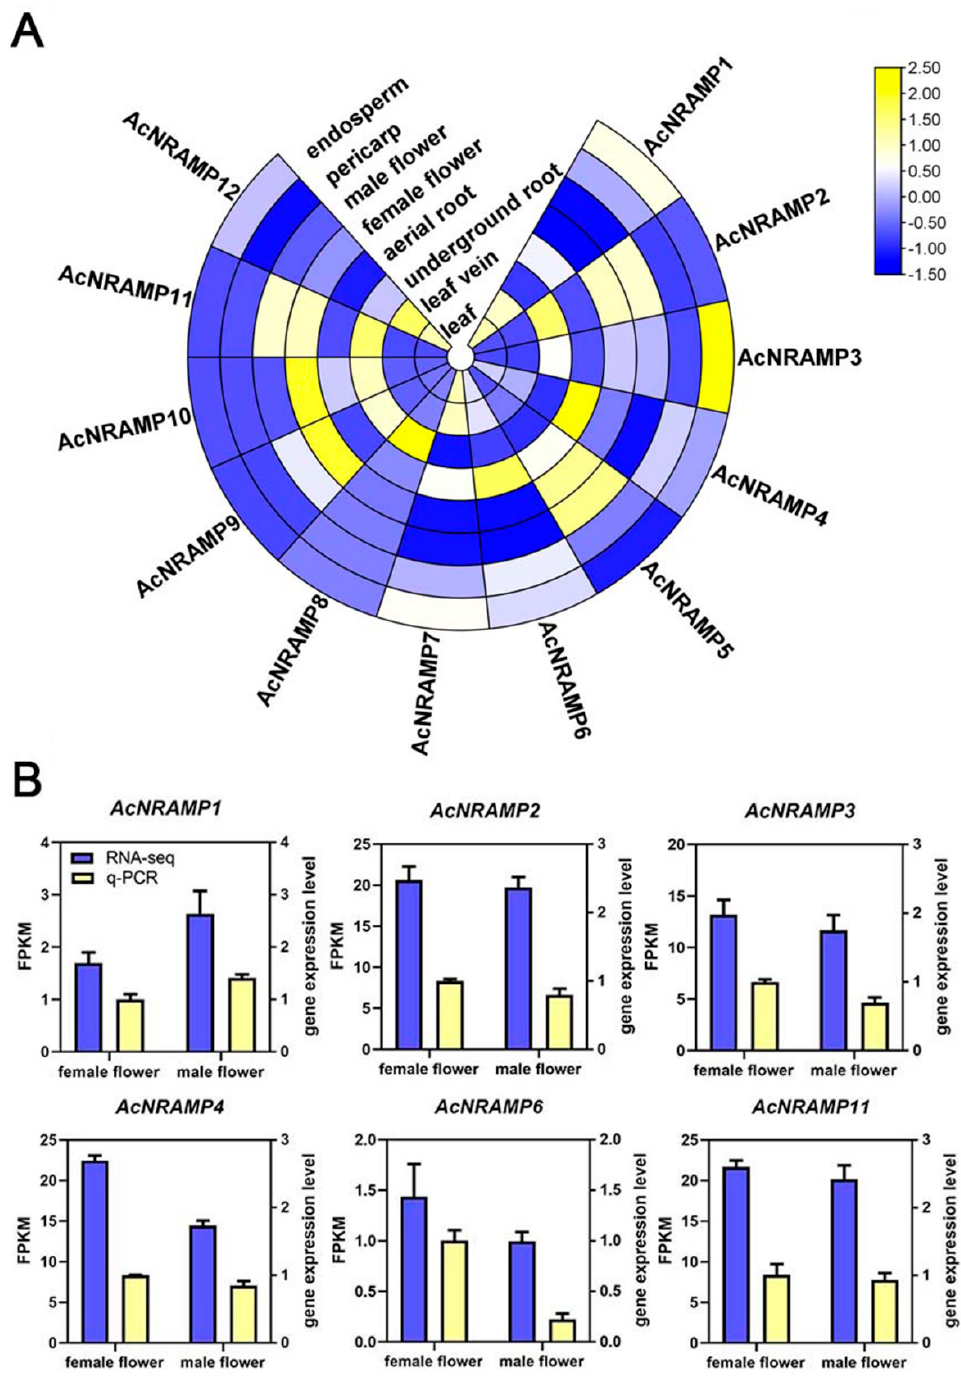
Figure 7. The expression patterns of 12 AcNRAMP genes of A. catechu in different tissue ( A ) and qRT-PCR validation of RNA-seq ( B ).